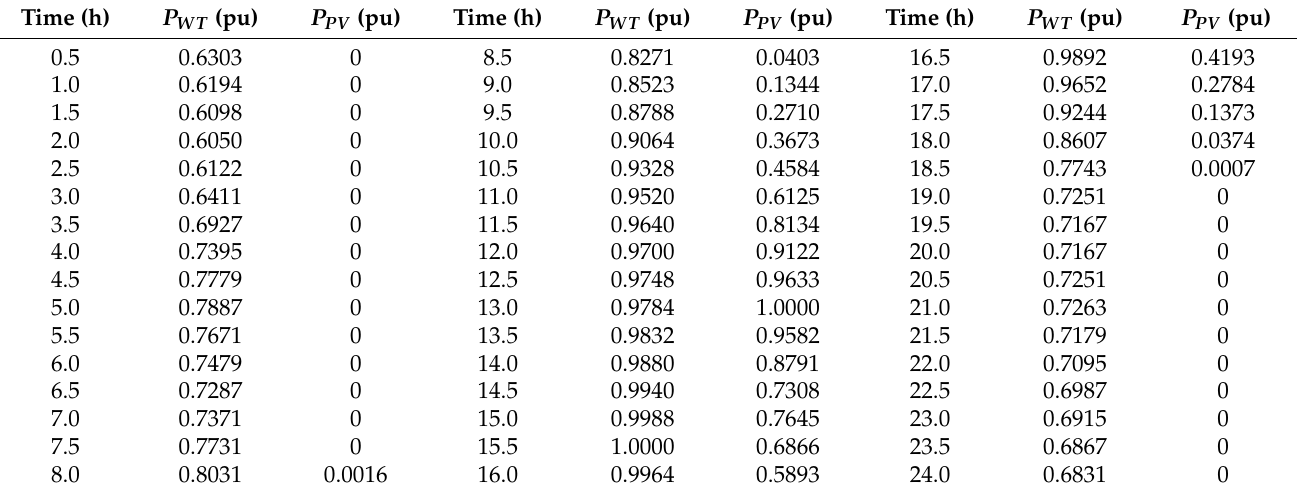
Table 5. Normalized Curve of generation: Wind power generator and PV